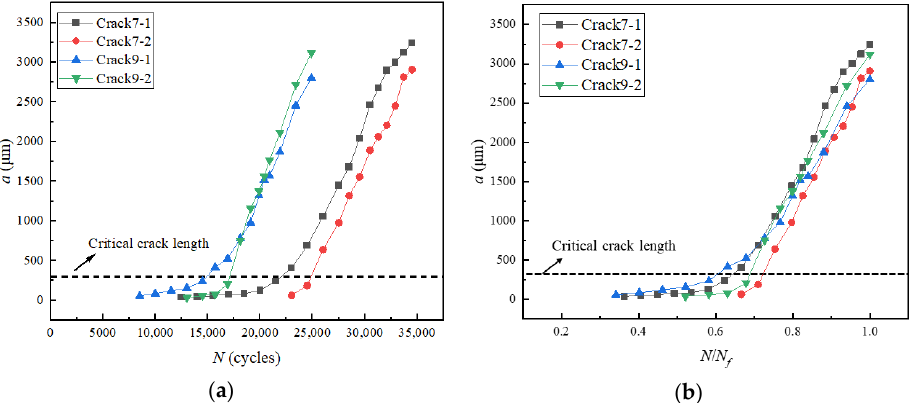
Figure 15. Variation of crack length of cruciform specimen with 0° waist circle hole notch in the central area. ( a ) Variation of crack length with cycle number. ( b ) Variation of crack length with cycle ratio.